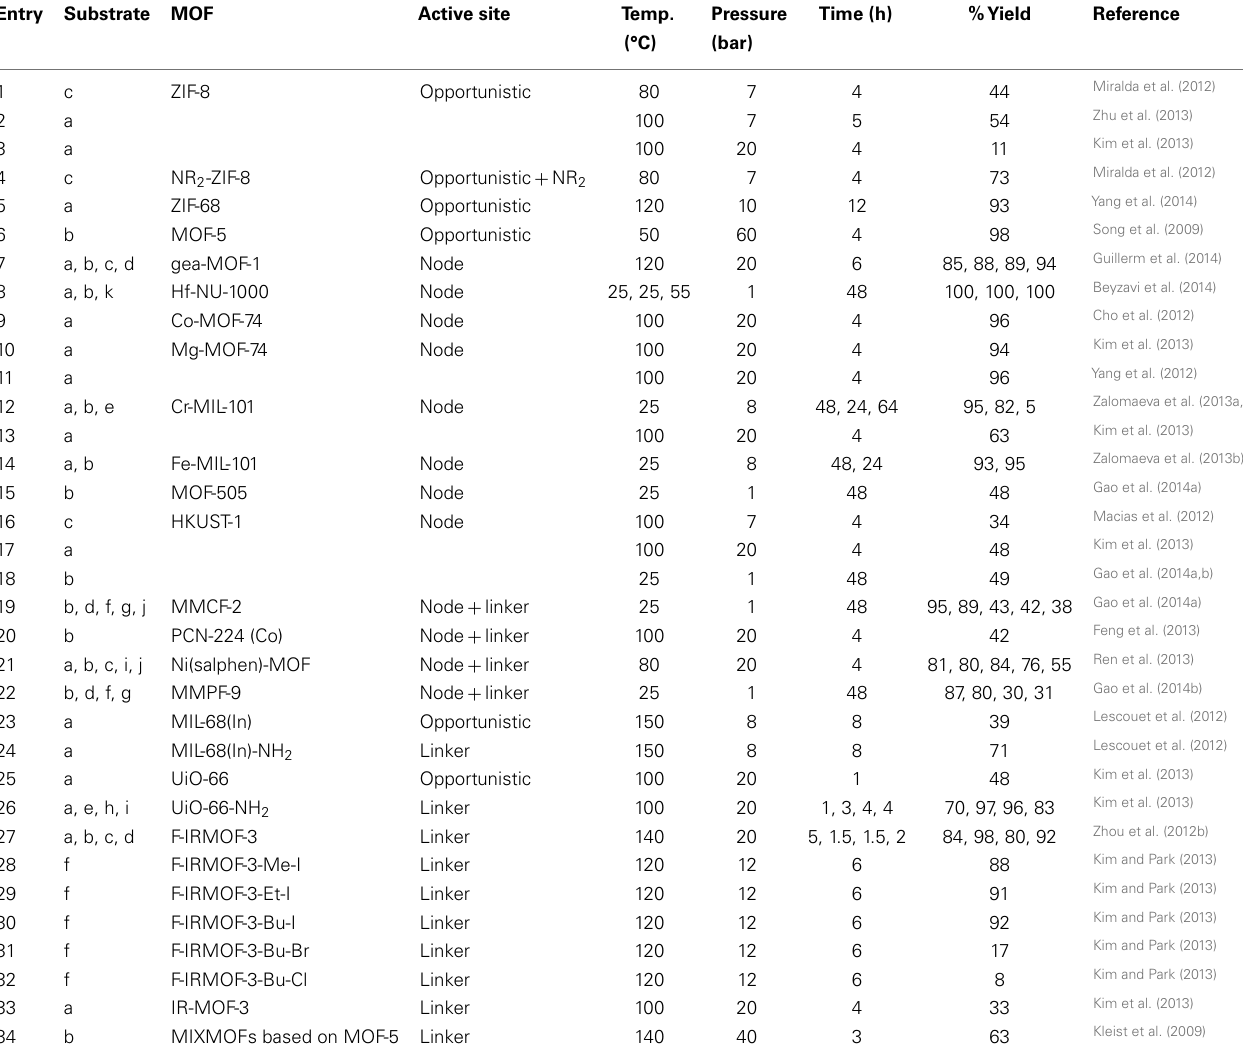
Table 2 | Conditions utilized for the CO 2 insertion into epoxides leading to OCs for each MOF